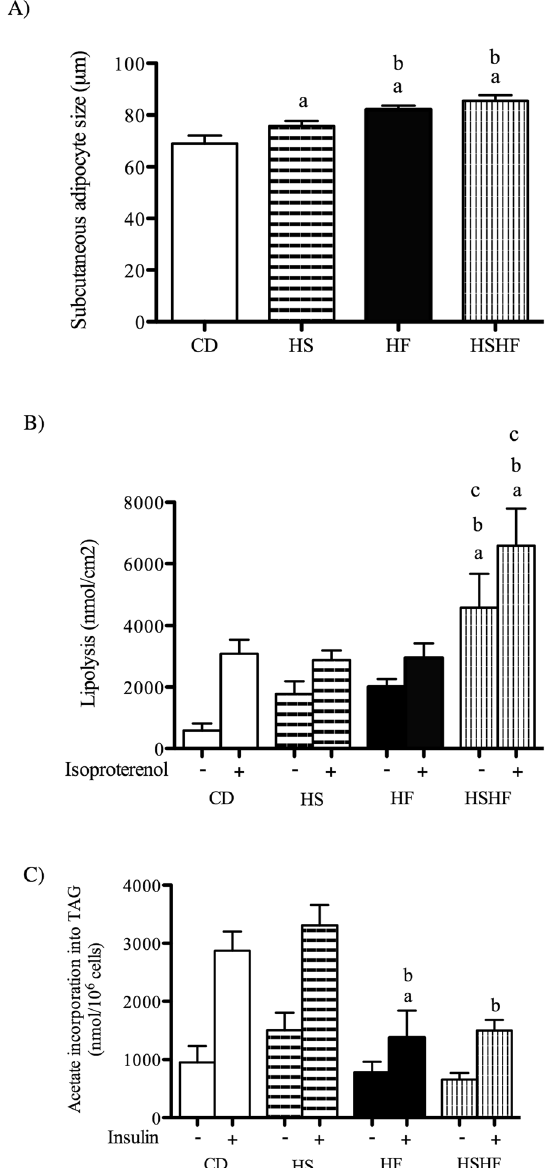
Figure 2. Inguinal adipocyte size ( A ), lipolysis ( B ) and lipogenesis ( C ) rates in mice fed the control diet (CD) or obesogenic diets (high-sugar (HS), high-fat (HF) and high-sugar/high-fat diet (HSHF) for 8 weeks. The results are expressed as the mean ± S.E.M. (n = 4–7/group). (a) P < 0.05 compared with CD, (b) P < 0.05 compared with HS, and (c) P < 0.05 compared with HF, using one-way ANOVA and Tukey’s